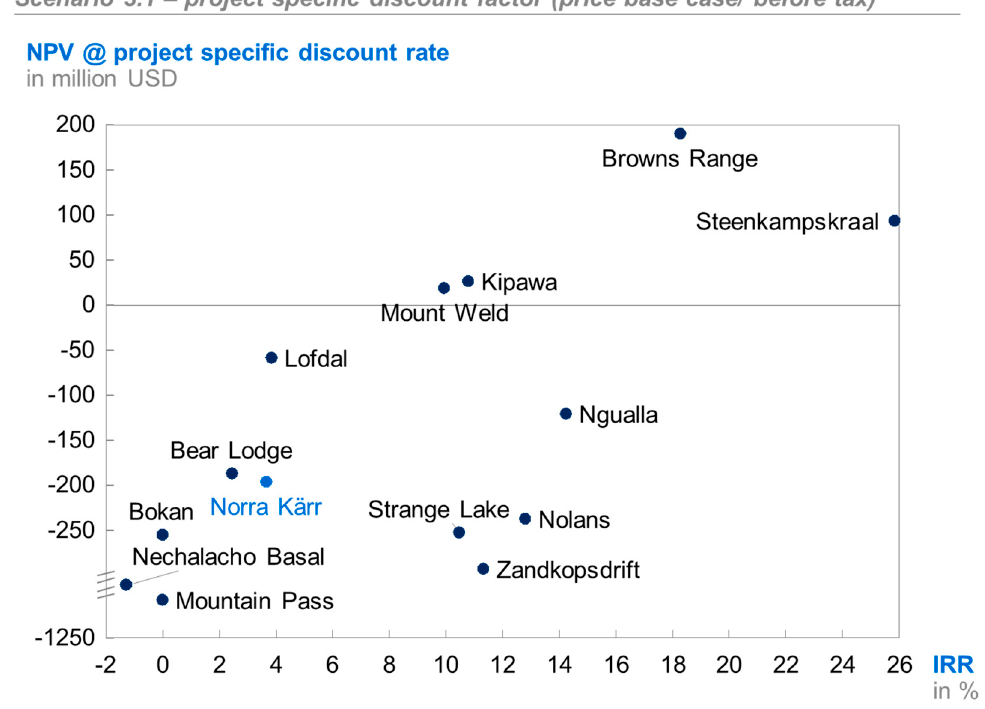
Figure 7. Base-case results of the DCF model with project-specific discount rates (pre-tax).